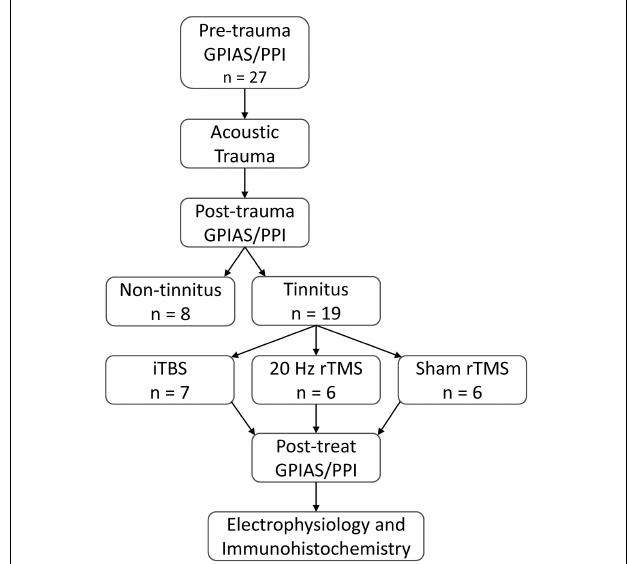
FIGURE 2 | Experimental overview. All animals tested for baseline GPIAS and PPI ensuring no pre-existing behavioral evidence of tinnitus and normal startle circuitry. Baseline behavioral tests were followed by an AT to induce hearing loss. Following hearing loss, animals were tested weekly for behavioural signs of tinnitus. Tinnitus animals were treated with active rTMS (20 Hz or iTBS) or sham rTMS administered over the PFC for 10 min daily, over 2 weeks (Monday to Friday). Following treatment, behavioral signs of tinnitus were assessed, along with spontaneous and burst firing rates of single neurons in the MGN, and subsequent post-euthanasia immunohistochemical analysis of calcium-binding proteins in the